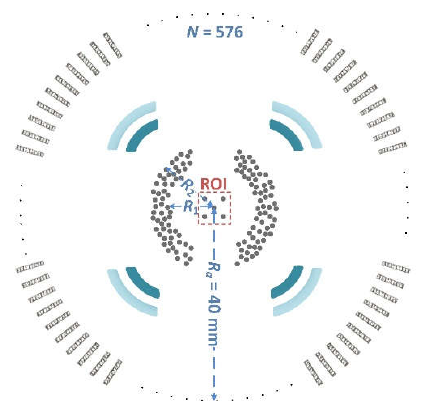
Figure 2. The schematic of the scenario of the simulation. Five identical optical absorbers with a diameter of d = 0.8 mm are placed in the ROI within a scattering layer. The inner and outside radius of the scattering layer are R 1 = 10 mm and R 2 = 15 mm, respectively. The ultrasound signal is detected by an annular array with a radius of R a = 40 mm .